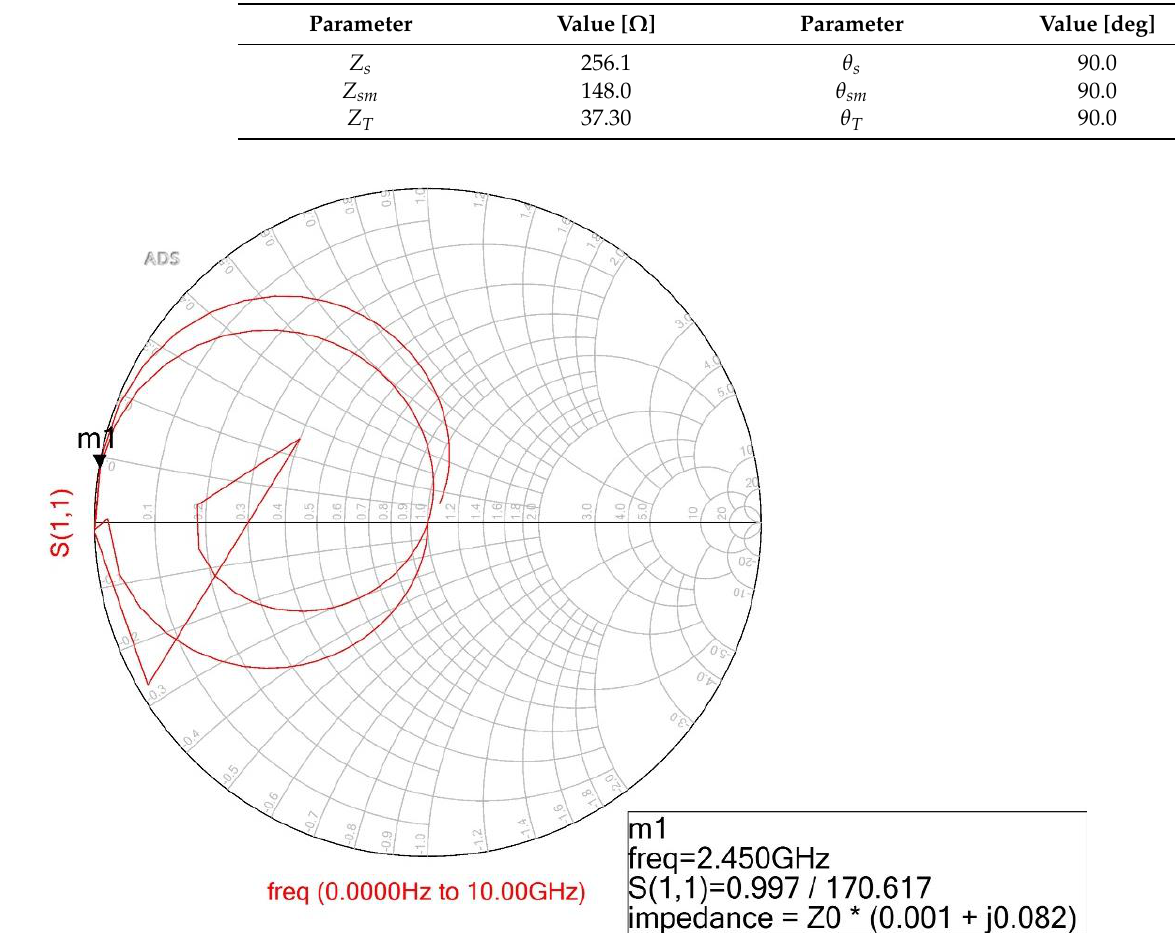
Figure 2. Simulation result for real and imaginary impedances for a conventional BPF.